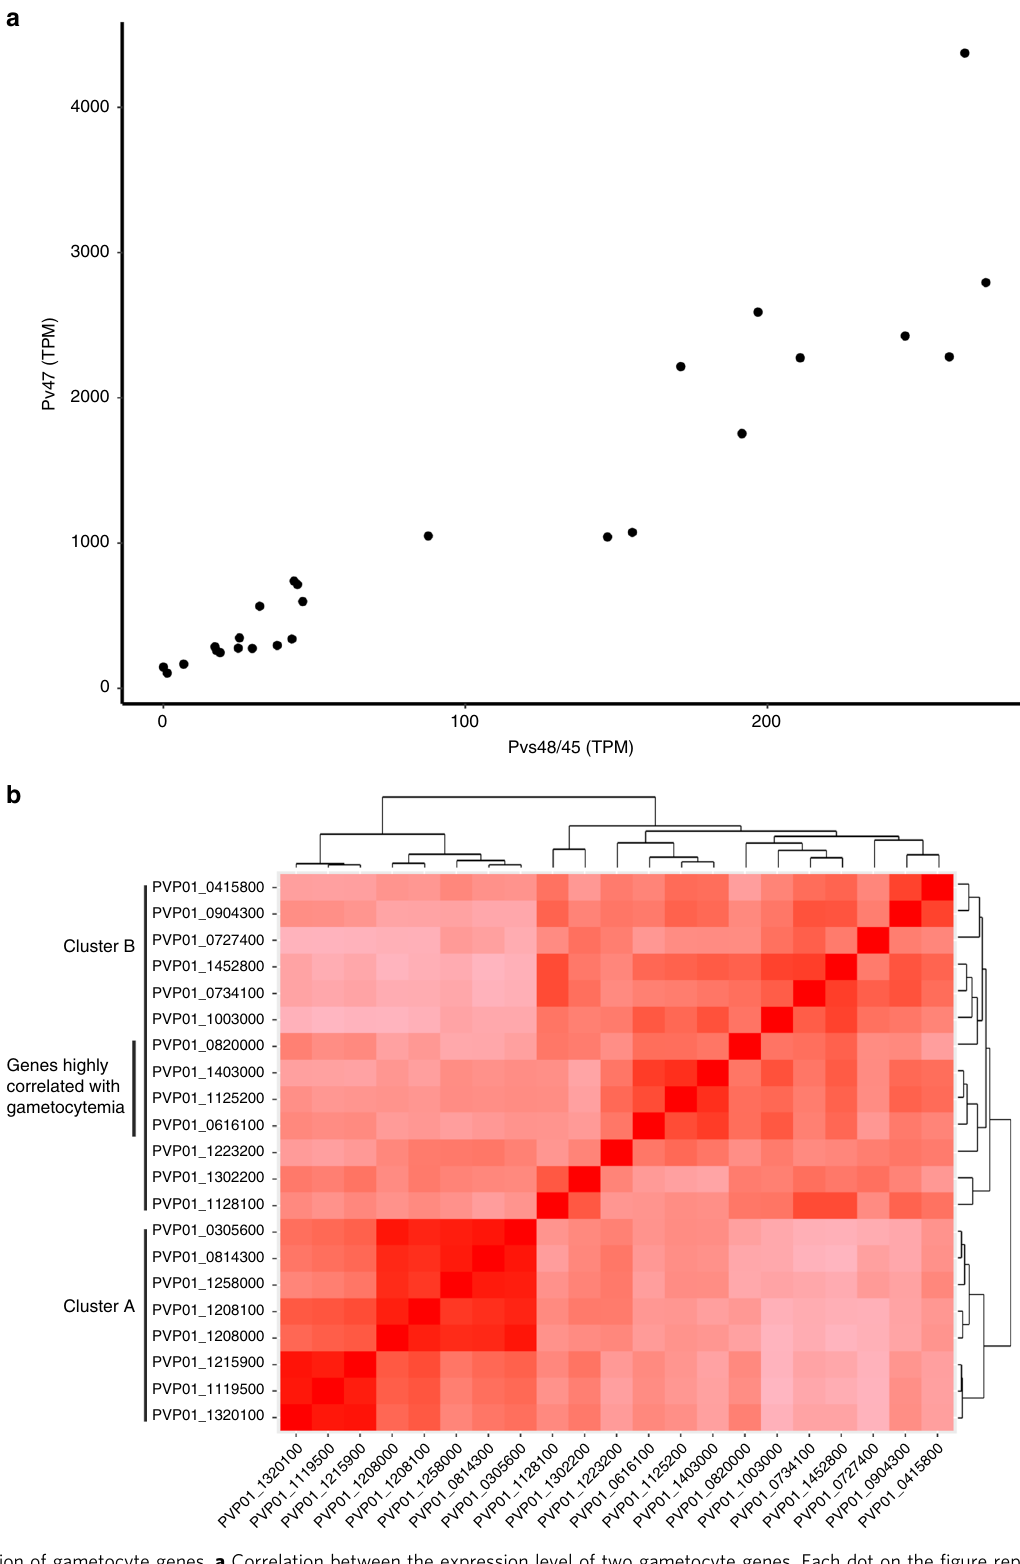
Fig. 2 Expression of gametocyte genes. a Correlation between the expression level of two gametocyte genes. Each dot on the fi gure represents a single P. vivax patient infection and is displayed according to the normalized gene expression values of Pvs48/45 ( x -axis) and Pvs47 ( y -axis). b Heatmap showing the extent of gene expression correlation (Pearson ’ s R , in red scale) among 21 gametocyte candidate genes. The bordering tree shows the results of unsupervised clustering of these genes according to their gene expression pattern. Genes whose expression levels are highly correlated with the gametocytemia determined by microscopy are also